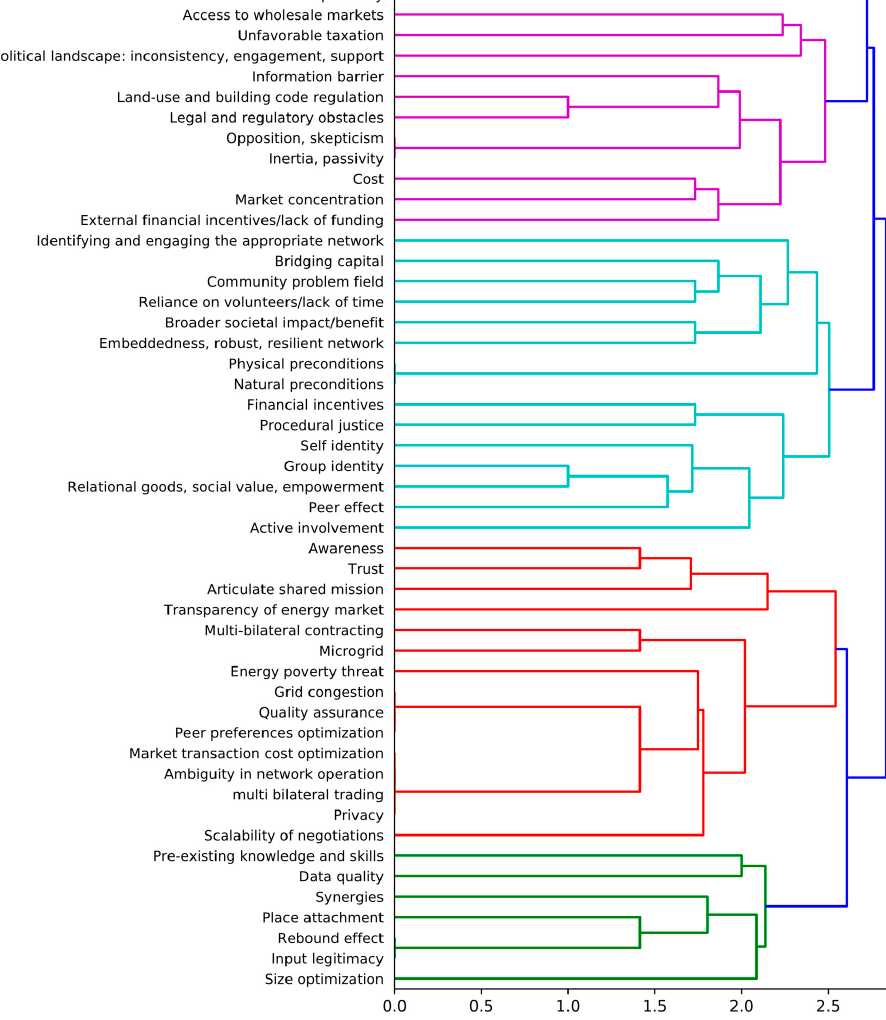
Figure 18. Agglomerative hierarchical clustering of progression factors by discipline, role, use-case, lifecycle phase.